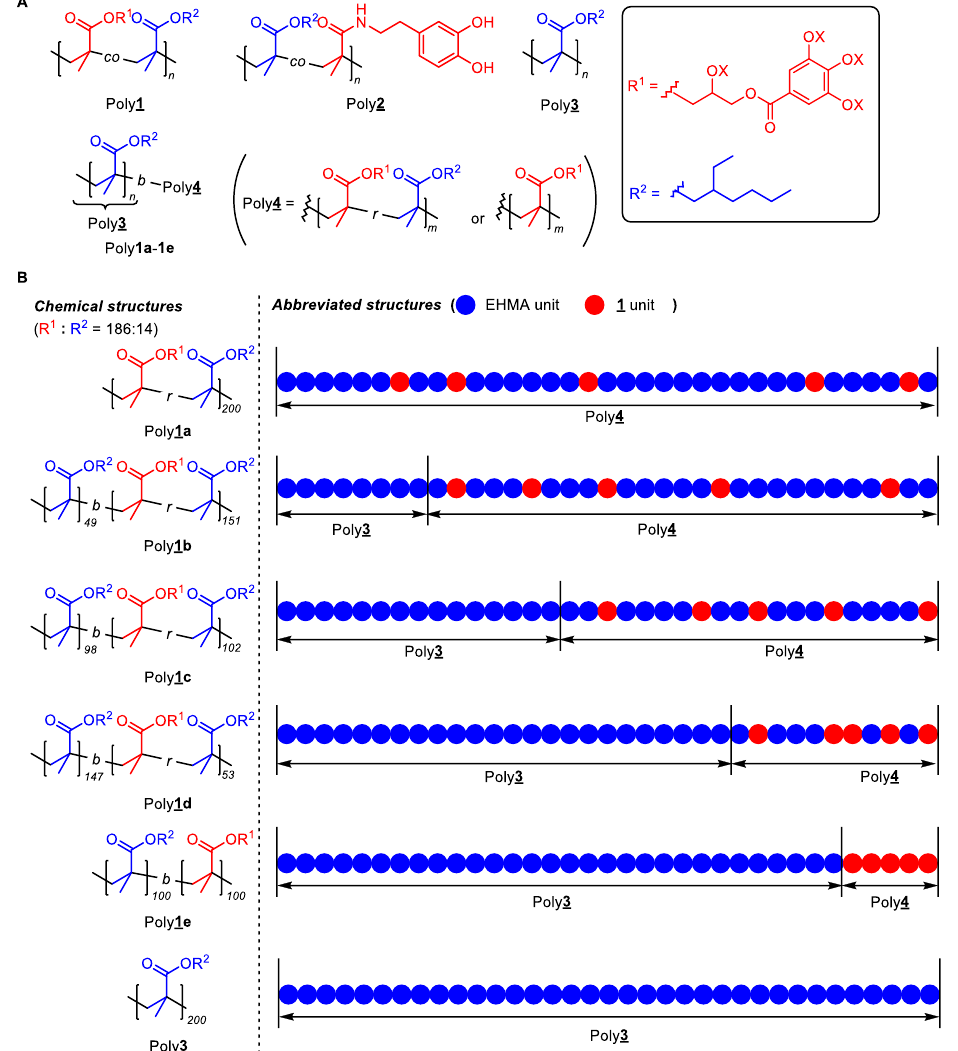
Figure 1. ( A ) Summary of the chemical structures of the polymers in this work. Poly 3 is a homopolymer domain of EHMA. Poly 4 is a random copolymer domain of EHMA and 1 in Poly 1a – 1e . ( B ) Chemical and abbreviated structures of synthesized copolymers Poly 1a – 1e .